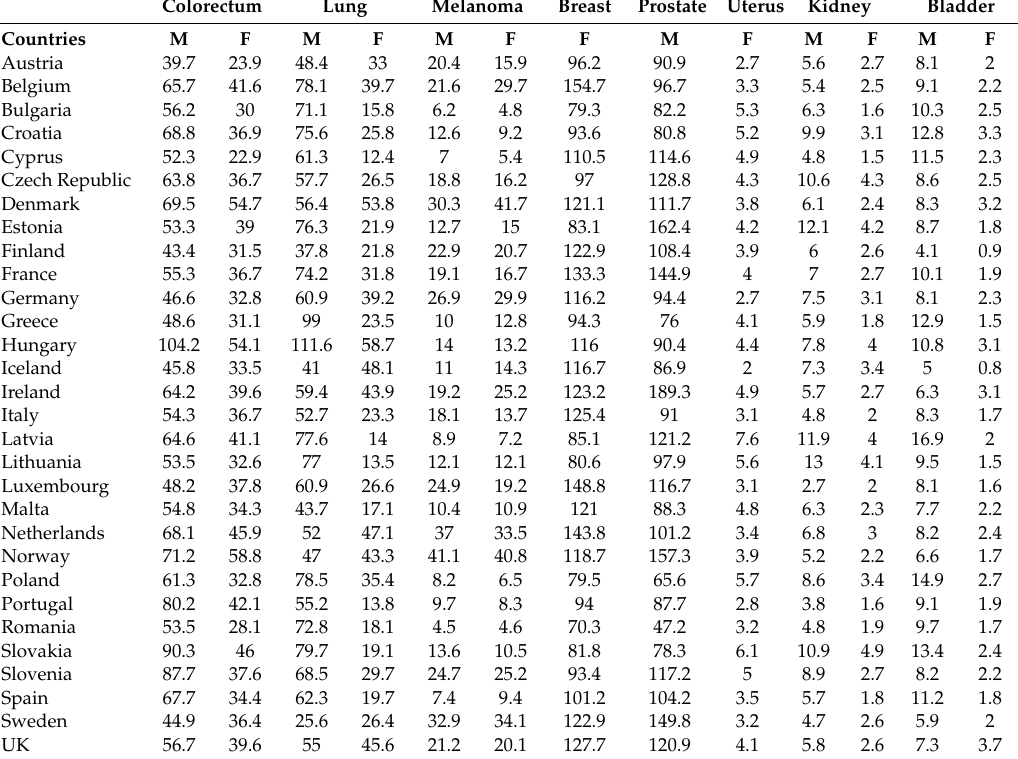
Table 1. Incidence of the most frequent cancer types as per 100,000 inhabitants / country (male / M / and female / F / ) in 30 European countries for